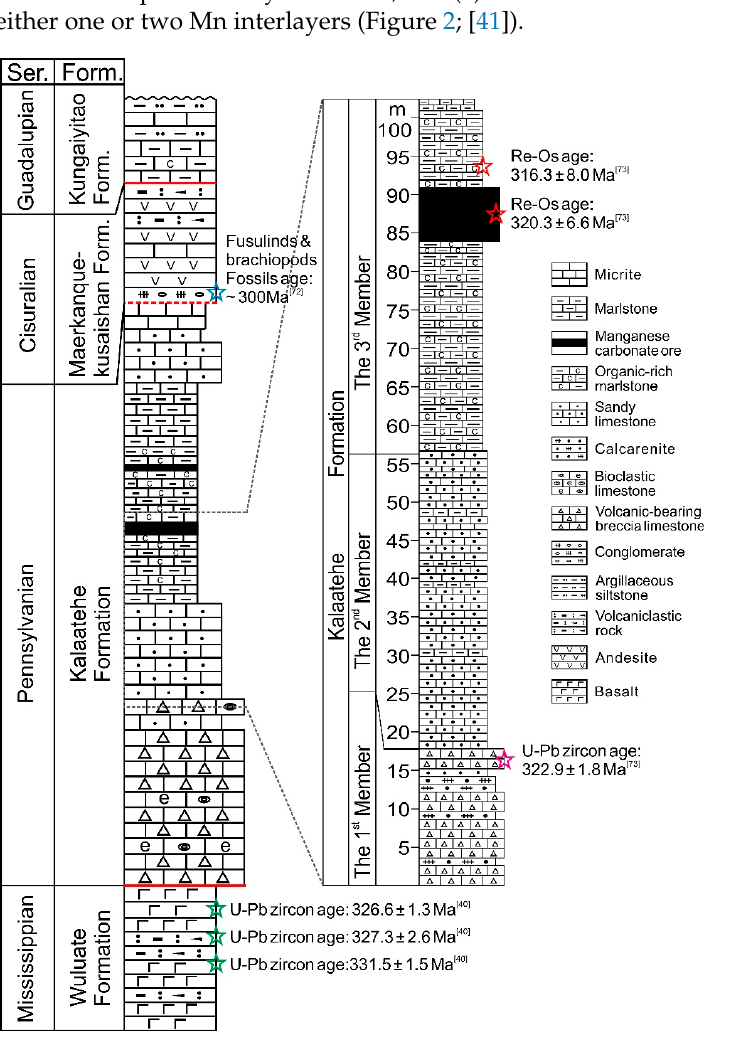
Figure 2. Stratigraphic succession for the Carboniferous to Permian volcano-sedimentary sequence of the Malkansu back-arc basin, highlighting the Kalaatehe Formation composed of three members and the interval of manganese mineralization (modified after [44]). Previously published age constraints are also listed, and these data are from